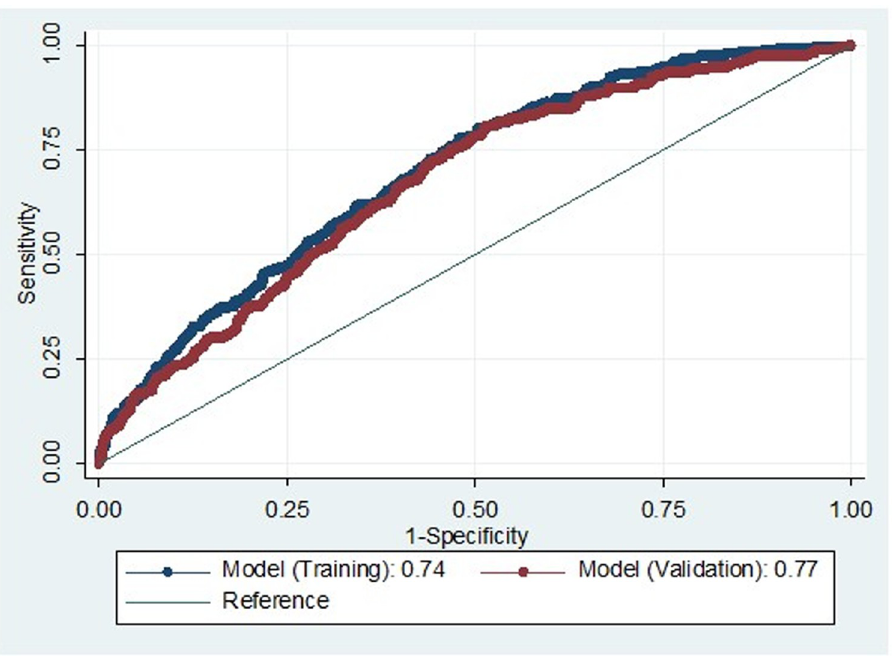
Fig 2. Comparison of the ROC curve for internal validation (training vs. validation) from multiple logistic regression: Emergency CS.